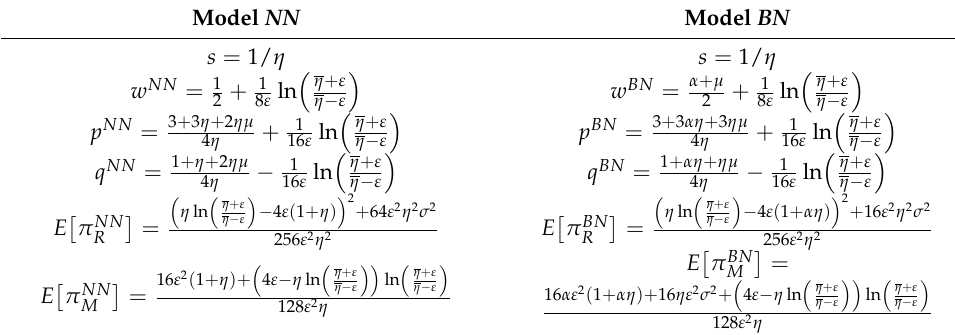
Table 4. Outcomes in Model iN ( i = N , B )